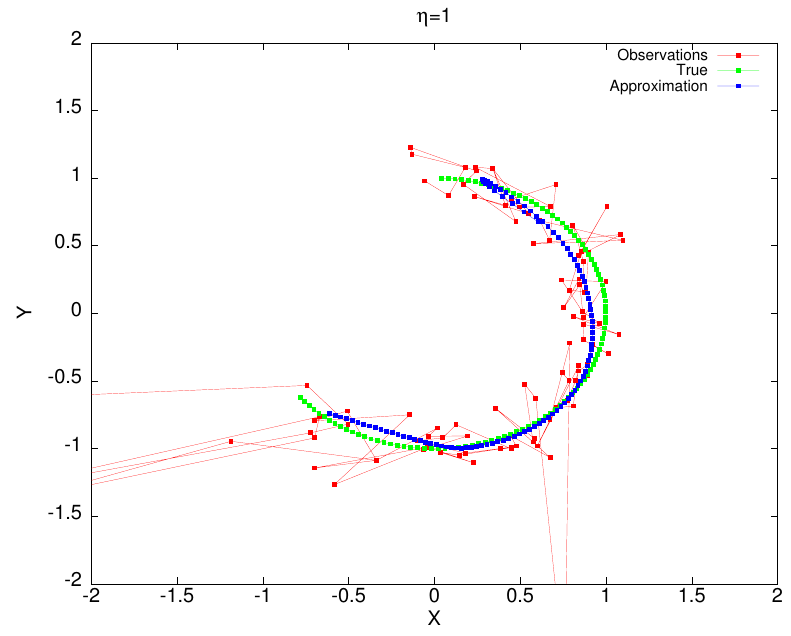
Figure 9. Performance of the shadowing filter in tracking an object using multiple bearing observations with η = 1, α θ = α θ (cid:48) = 0.05. Note how the filter is able to overcome the singularities in the observations and estimates the true dynamics quite